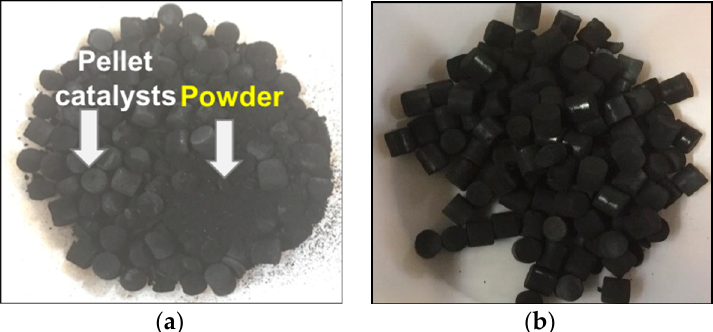
Figure 3. Image of pellet-shaped catalyst collected after ( a ) steam reforming at 800 °C, S/C = 3.0, and O 2 /C = 0.2; and ( b ) auto-thermal reforming at 800 °C, S/C = 3.0, and O 2 /C = 0.2.